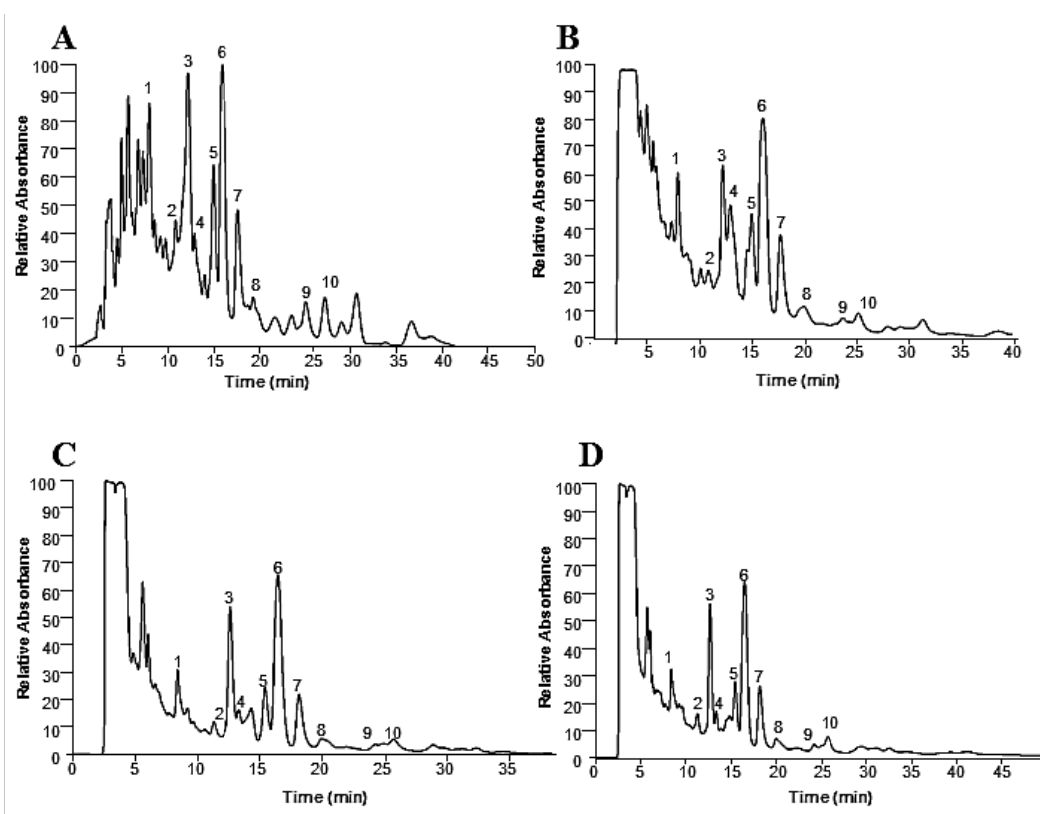
Figure 1. LC-PDA chromatograms at 210 – 220 nm of the neem leave extracts obtained by PLE. SH ( A ), SEA ( B ), SE ( C ), and EE ( D ).